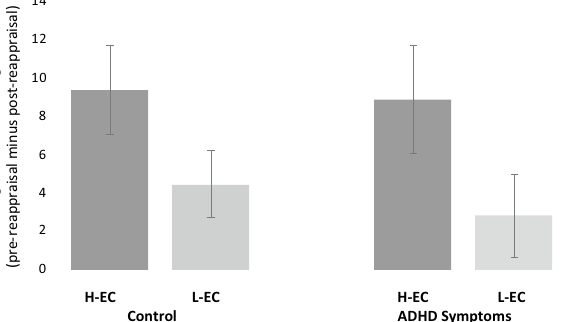
Figure 3. Comparison between the control and ADHD symptoms groups in the two training conditions (H-EC vs. L-EC). The figure shows participants’ self-reported change in negative mood. Change scores = ratings after writing the event (pre-reappraisal) minus ratings after the instructed reappraisal assignment (post-reappraisal). Higher positive values indicate a larger reduction in negative mood. Error bars represent standard